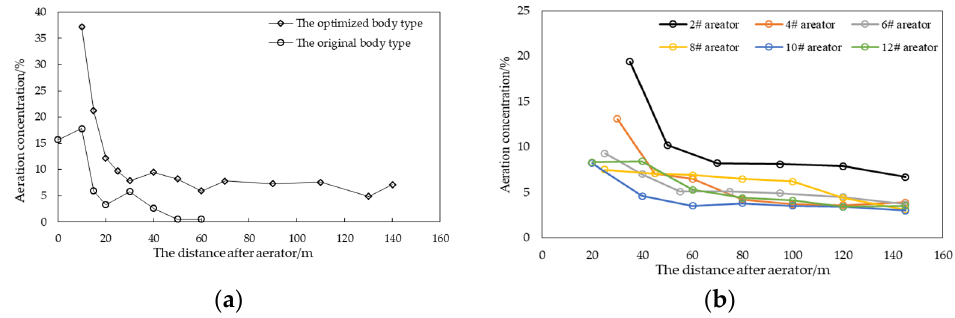
Figure 10. The aeration concentration distribution after the aerator: ( a ) aerator 1; ( b ) aerators